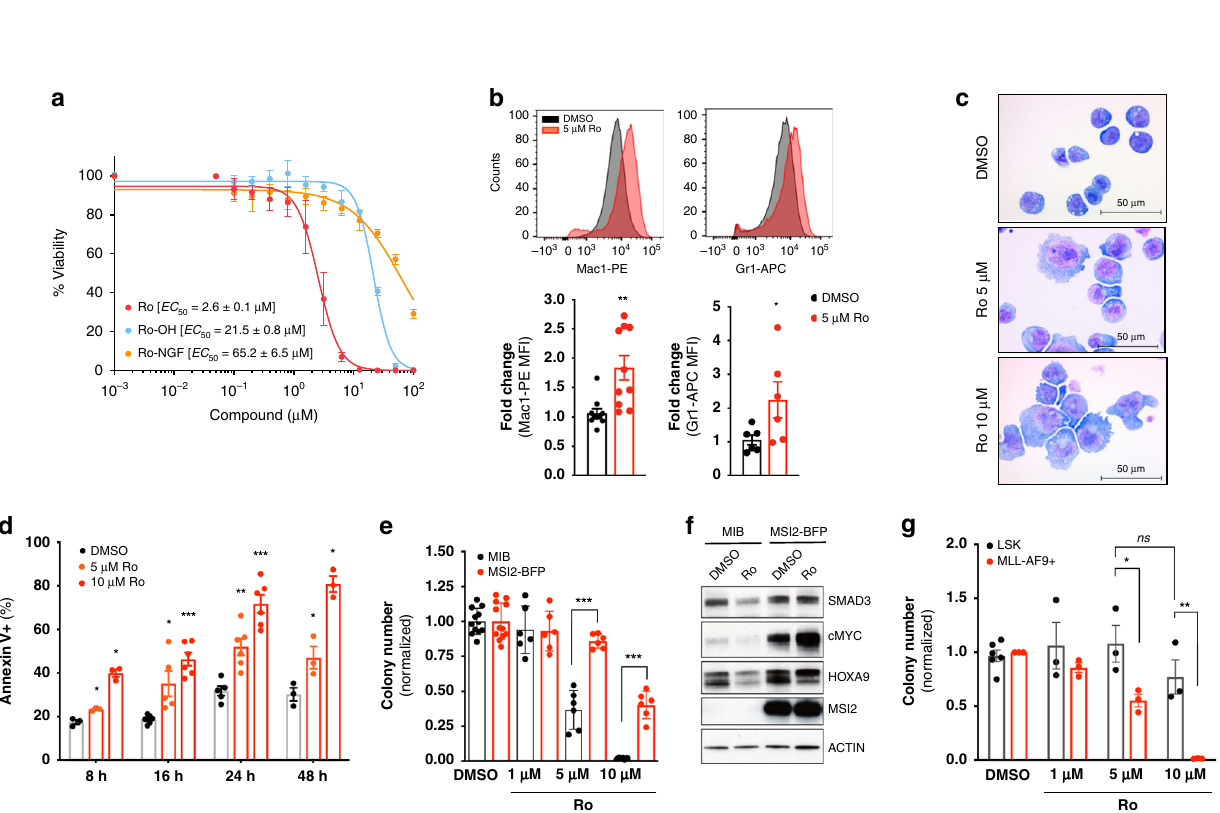
Fig. 3 Ro 08 – 2750 increases differentiation and apoptosis in myeloid leukemia cells. a Cytotoxicity assay (Cell-Titer Glo) of Ro ( red ), Ro-OH ( cyan ) and Ro- NGF ( orange ) in MLL-AF9 + BM cells. 50% Effective Concentration ( EC 50 ) values, average of at least three independent experiments ± standard deviation are shown. b Flow cytometry representative histograms of DMSO ( gray ) and 5 μ M Ro ( red ) treated MLL-AF9 + BM cells with myeloid differentiation markers (Mac1 and Gr1); bar graphs ( below ) show average (fold change increase)± standard error mean of three independent experiments, performed in triplicate. Paired t -test, * p < 0.05; ** p < 0.01. c Representative immunocytochemistry images of cytospun MLL-AF9 + BM cells control (DMSO) or Ro treated (5 and 10 μ M) and stained by Eosin Y and Methylene Blue/ Azure A. Scale, 50 μ m. d Apoptosis analysis by Annexin V + (% population) for MLL- AF9 + BM cells cultured in absence (DMSO, black ) or presence of Ro 5 μ M ( light red ) or 10 μ M ( red ). Results represent at least three independent experiments ± s.e.m. e Colony Formation Unit (CFU) assay of MLL-AF9 + Puro-CreER + Msi1 fl / fl Msi2 fl / fl BM cells transduced with MSCV-IRES-BFP (MIB, control) or MSCV-IRES-MSI2-BFP (MSI2-BFP) retroviral vectors after Ro treatment 1, 5 and 10 μ M. Results represent the average ± s.e.m. of colony numbers of at least fi ve experiments performed in duplicate. f Representative immunoblot of MLL-AF9 + Puro-CreER + Msi1 fl / fl Msi2 fl / fl BM MIB ( black bars ) and MSI2-BFP ( red bars ) cells (used in panel e ) after DMSO or 10 μ M Ro treatment for 4 h. β -ACTIN, loading control. g CFU assay of Lin - Sca + cKit + (LSK) versus MLL-AF9 + BM cells demonstrates Ro 08 – 2750 therapeutic window. Results represent the average ± s.e.m. of colony numbers of three experiments performed in duplicate. Two tailed Paired t -test ( b , d , e and g ), * p < 0.05, ** p < 0.01, *** p < 0.005. Source data are provided as a Source Data fi